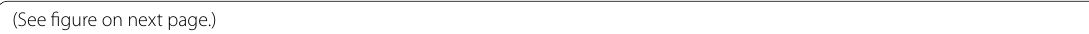
figure on next Fig. 6 OLMALINC elevated OCT4 protein level via inhibiting its ubiquitination. A, B Len-sh-ctrl or Len-sh- OLMALINC transfected human renal interstitial fibroblasts (hRIFs) were pretreated with CHX (10 μM), and OCT4 was determined by Immunoblotting (IB) at the indicated time points (n 3). C, D HRIFs transfected with Len-sh-ctrl or Len-sh- OLMALINC were treated with the proteasome inhibitor MG-132 (10um/ml) for 8 h or = not, and OCT4 was determined by IB (n 3). E HRIFs transfected with Len-sh-ctrl or Len-sh- OLMALINC were treated with MG-132 for 8 h, and the = cell lysis was collected for immunoprecipitation (IP; n 4). The immune-precipitates of anti-OCT4 or IgG (negative control) were incubated with = anti-ubiquitin. F IB analysis of OCN, BMP2 and RUNX2 in hRIFs with overexpressed or silenced OLMALINC 7 days after osteogenic induction (n 3). = G Alkaline phosphatase (ALP) activity of hRIFs with overexpressed or silenced OLMALINC 7 days after osteogenic induction (n 3). H Alizarin Red = Staining (ARS) for calcium nodes in hRIFs with overexpressed or silenced OLMALINC 14 days after osteogenic induction (n 3). I Representative = co-staining images of RNA FISH for OLMALINC (Red) and immunofluorescence for Vimentin (Green) in Randall’s Plaques (RP; n 6) and normal renal = papillae (NRP; n 6). J QRT-PCR analysis of OLMALINC expression in RP (n 28) and NRP (n 28). K Liner regression analysis of OLMALINC expression = = = and OCT4 protein density in RP (n 18) and NRP (n 18). L Linear regression analysis of OLMALINC expression and OCT4 mRNA expression in RP = = (n 28) and NRP (n = =